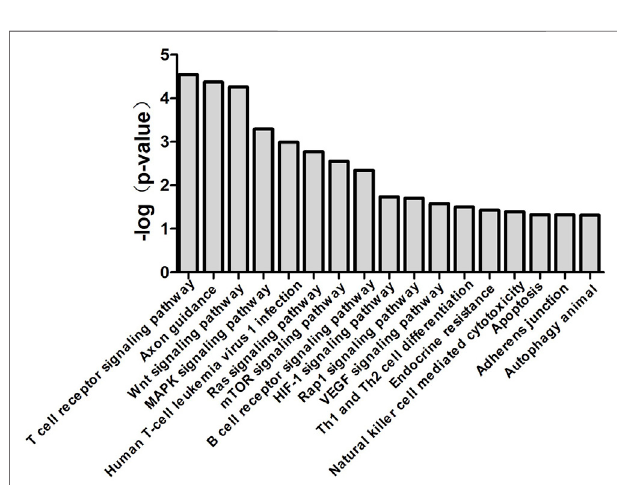
FIGURE 6 | Canonical pathways associated with miR-483-3p and let- 7d-3p generated by bioinformatics analysis. Top 17 over-represented biological pathways for gene targets of elevated miR-483-3p and let-7d-3p were depicted in the bar graph. Data are presented as the negative log p -value generated from the Fisher ’ s exact test. Pathways which were more closely associated with the gene targets had higher values.